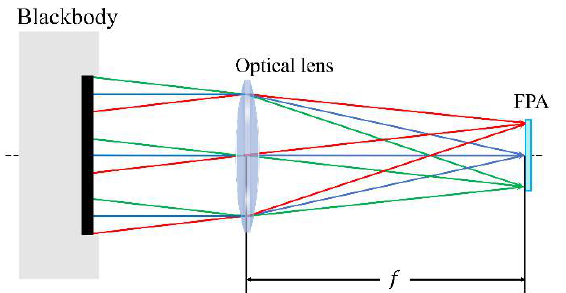
Figure 2. Schematic diagram of radiometric calibration using the near-extended area blackbody with geometric distribution of infrared radiation transmission.